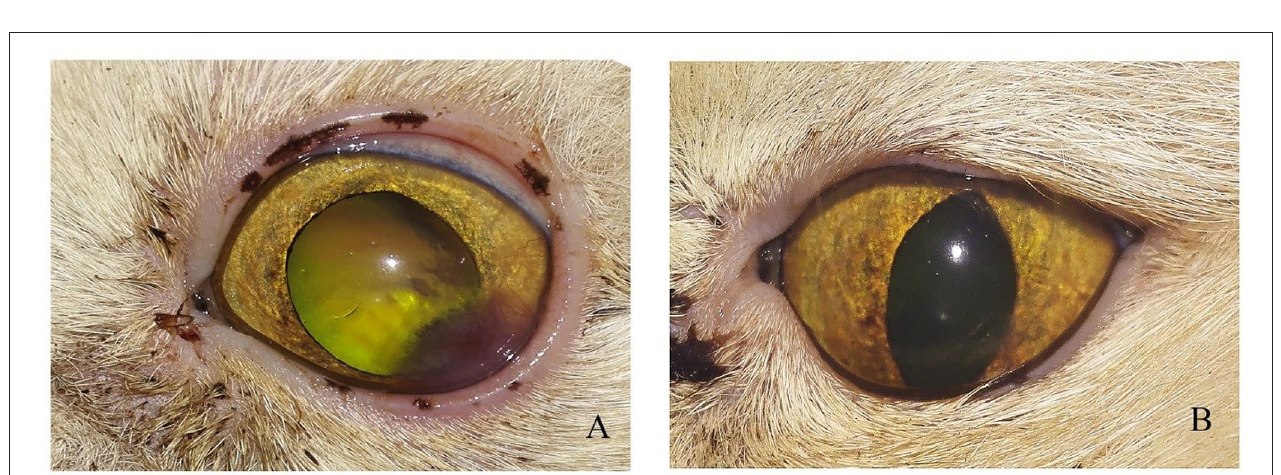
FIGURE 5 | Photographs of a short hair cut showing (A) Stromal ulcer (B) complete healing of ulcer after 1 month of injection.